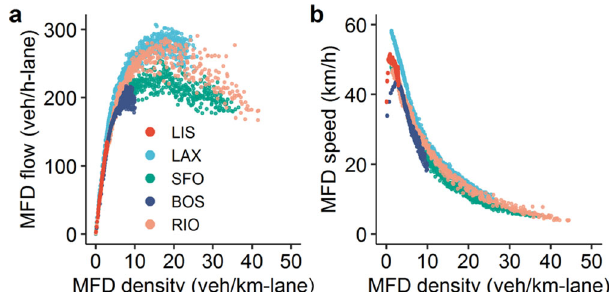
Fig. 3 An analysis of the average traf fi c performance of the central business district of each city. a Depicts the measured macroscopic fundamental diagram (MFD) fl ow versus vehicle density of each city. Note that Lisbon and Boston do not reach the congested branch of the